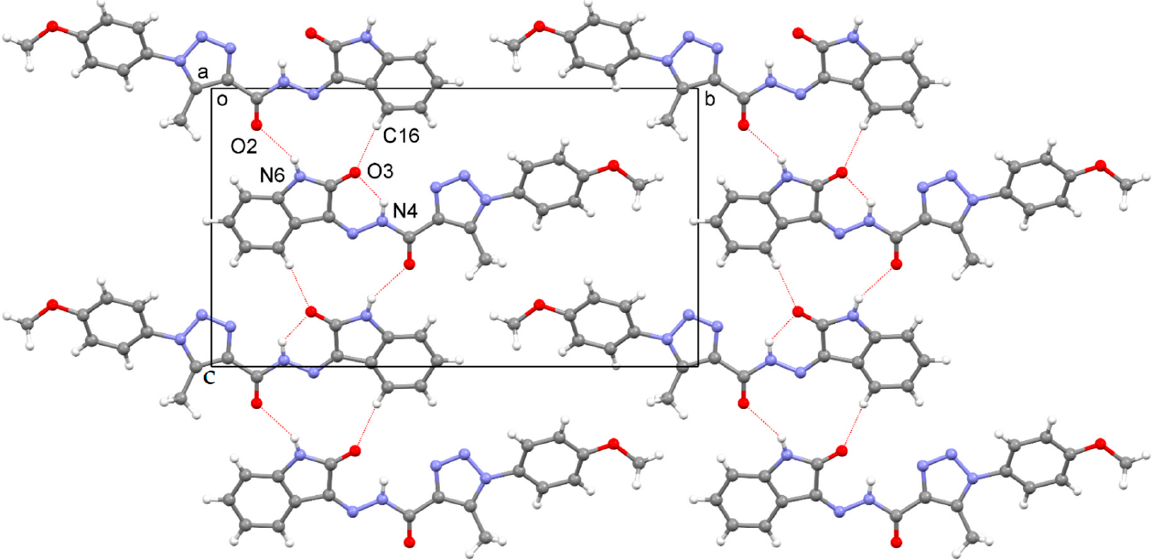
Figure 2. A segment of the crystal structure of 3 , viewed down the a , axis, showing a layer with contacts shown as red dotted